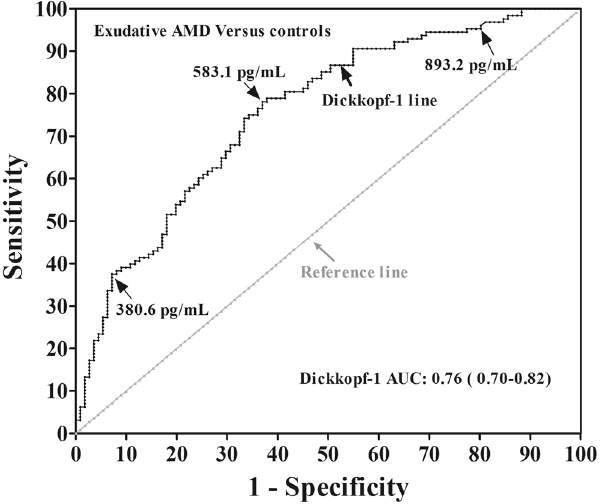
Figure 4. ROC analysis of plasma DKK-1 levels for the diagnosis of exudative AMD. The ROC curve was drawn with the data of 128 exudative AMD patients and 111 healthy controls. Each point on the ROC curve represents the sensitivity vs. False positive rate (1-specifity), corresponding to the cut-off value. ROC = receiver- operating-characteristic curve; AMD = age-related macular degeneration; AUC = area under the ROC